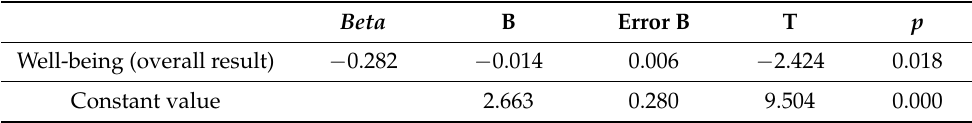
Table 11. PTSD predictors (individuals with anxiety) ( n = 70 in each group).